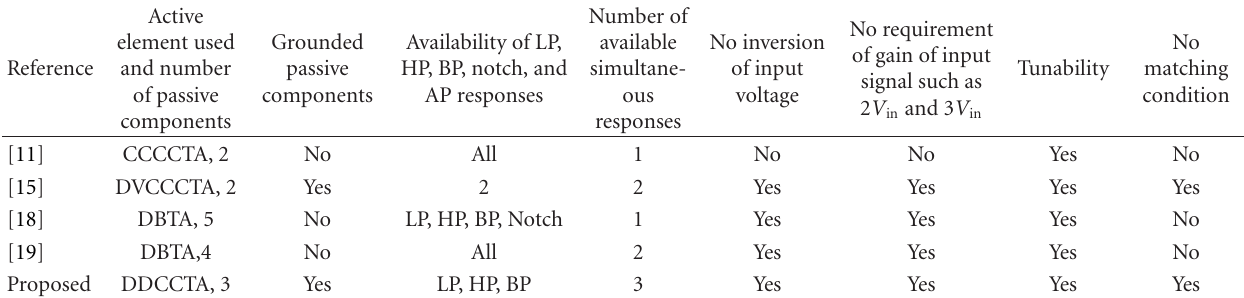
Figure 9: Simulated responses of the proposed current mode universal filter: (a) low pass and band pass; (b) high pass and band pass; (c) notch; (d) all pass. Table 3: Comparative study of the available similar type of single-active-element-based VM